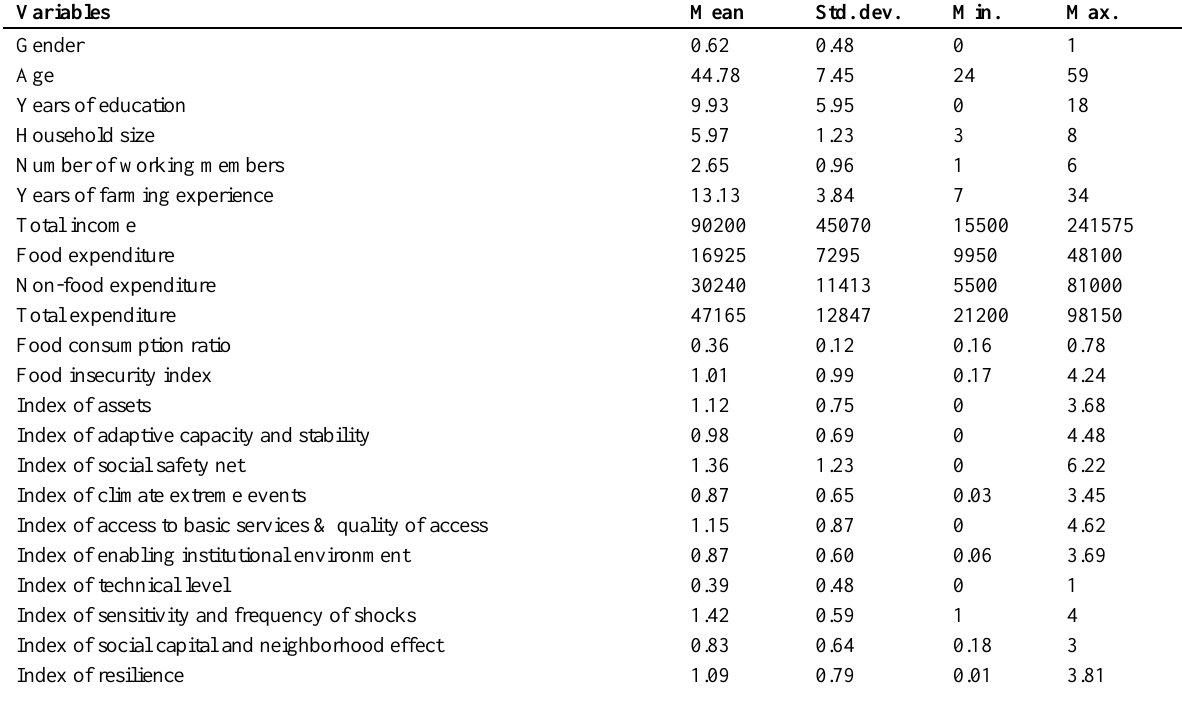
Table 2a: Farmers’ personal and socio-economic features and resilience components Variables Mean Std. dev. Min.